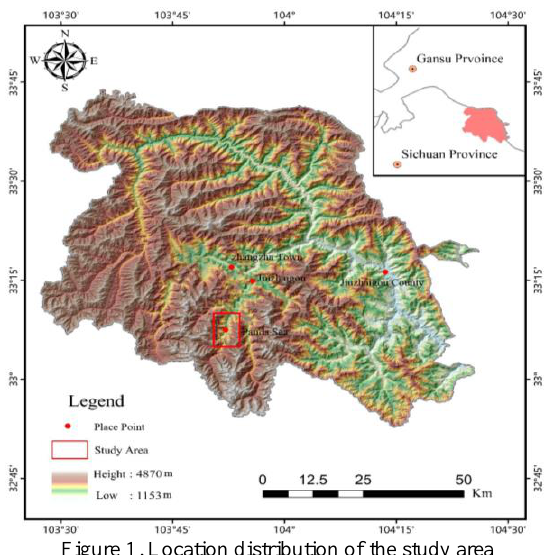
Figure 1. Location distribution of the study